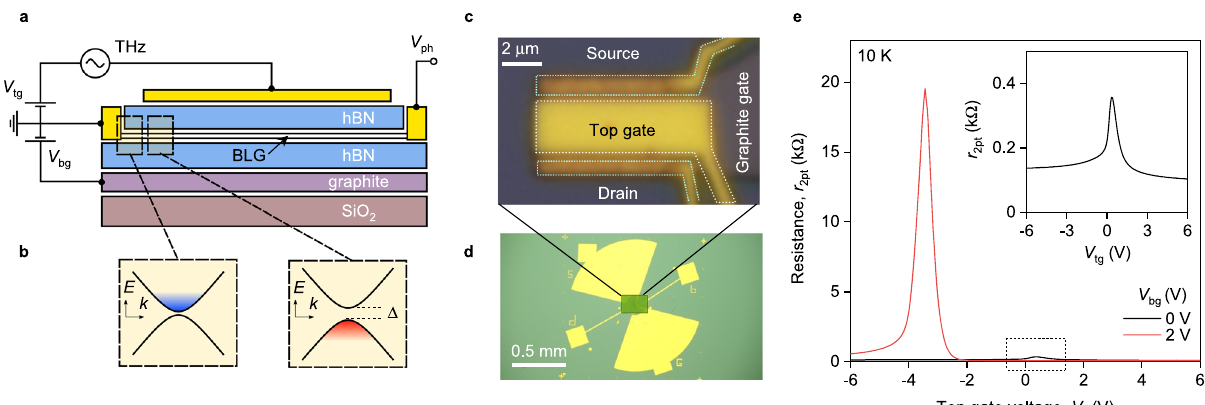
Fig. 1 Dual-gated bilayer graphene THz detector. a Schematic of an hBN encapsulated dual-gated BLG transistor. THz radiation is incident on a broadband antenna connected to the source (S) and gate terminals yielding modulation of the top gate-to-source voltage ( V tg ) while the back gate voltage ( V bg ) is fi xed. The build-up photovoltage V ph is read out between the source and drain (D) terminals. b Band structure of the BLG at the interface between the n- doped bottom gate-sensitive region and dual-gated p-doped channel ( Δ is the induced band gap). Blue and red colours illustrate conduction and valence bands fi llings, respectively. Note, even for a single-gated region, a fi nite band gap appears in the energy dispersion due to the difference in on-site energies between the top and bottom graphene layers 44 . c , d Optical photographs of the fabricated dual-gated detector. The source and top-gate terminals are connected to a broadband bow-tie antenna. e The two-terminal resistance of our BLG device, r 2pt , as a function of V tg for two representative V bg = 0 and V = 2 V. Inset: Zoomed-in r V V = 0 V. T = 10 K. bg 2pt ( tg ) for bg